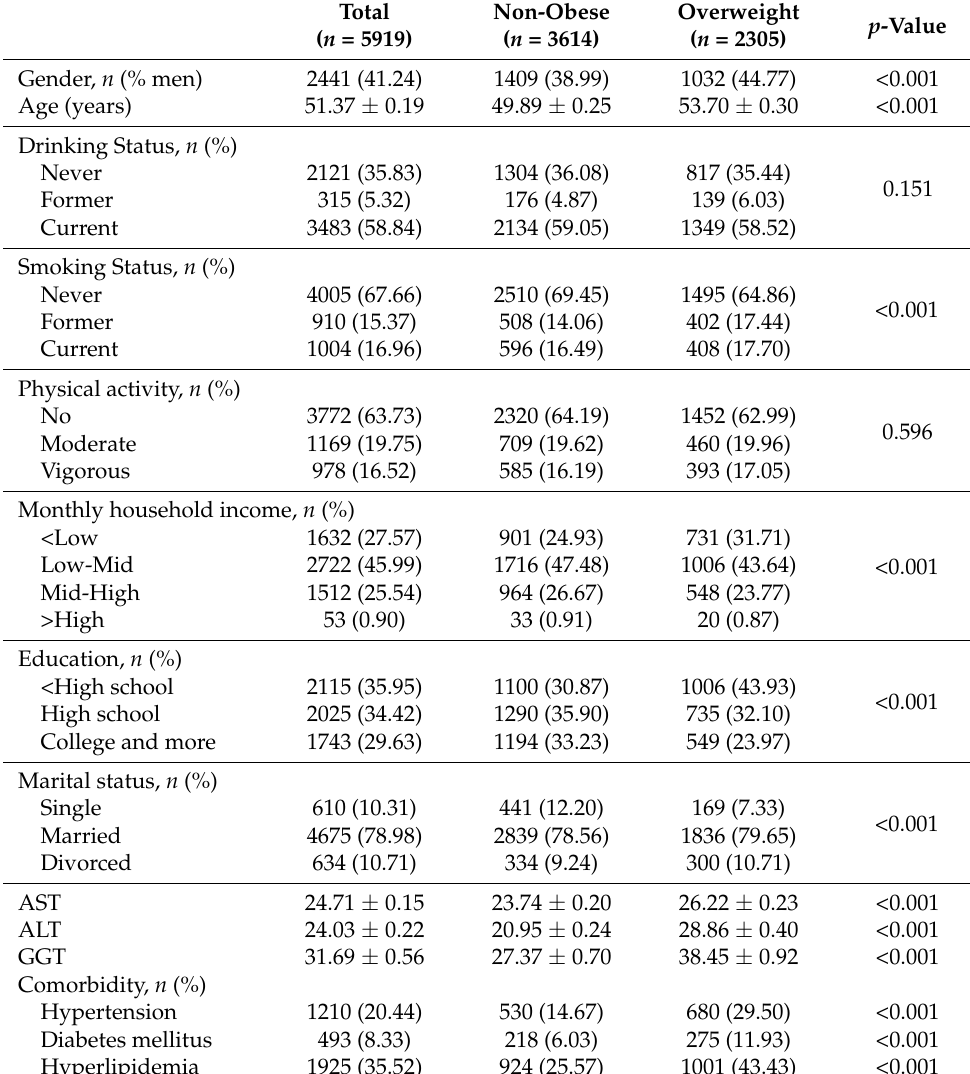
Table 1. General characteristics of study participants according body mass